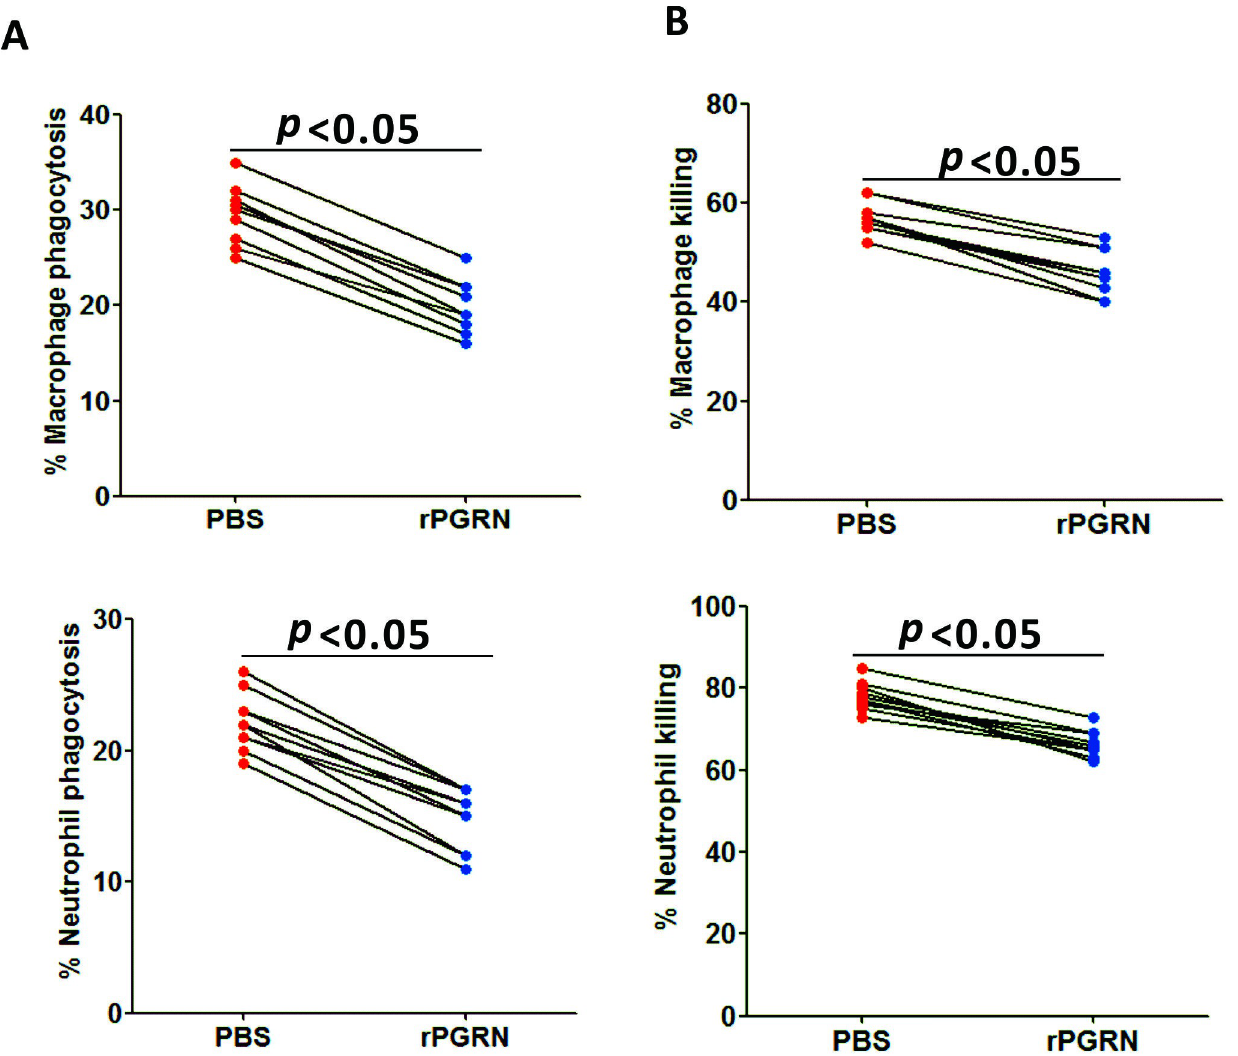
Fig 9. PGRN enhanced the phagocytic and killing activity of human macrophages and neutrophils in response to fungal infection. (A) Human monocyte-derived macrophages and neutrophils isolated from 10 healthy volunteers were preincubated with recombinant human PGRN (100 ng/ml) for 2 hours and challenged with FITC-labeled heat-killed C . albicans yeast at a multiplicity infection of 1:2 for 45 minutes, and the percentage of fungal phagocytosis was calculated. (B) Human monocyte-derived macrophages and neutrophils isolated from 10 healthy volunteers were preincubated with recombinant human PGRN (100 ng/ml) for 2 hours and challenged with live C . albicans at a multiplicity infection of 1:10 overnight, and the percentage of fungal killing was calculated. Wilcoxon signed-rank test was used to analyze the statistical difference, and p values were shown when compared between groups denoted by horizontal